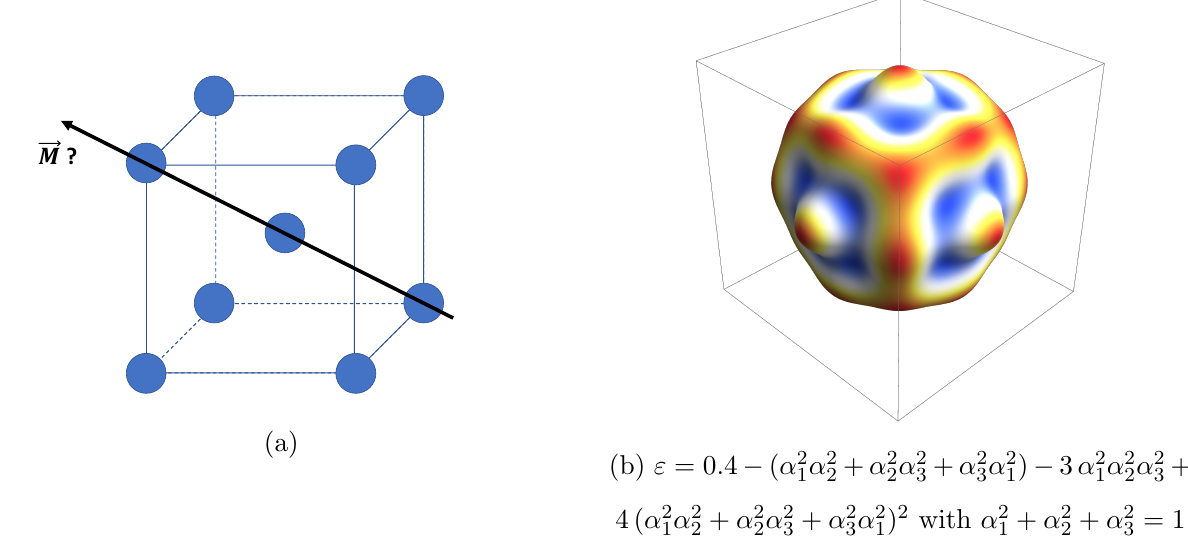
Fig. 1. Left: Schematic of a bcc crystal unit cell, with the overall magnetisation vector being oriented along one of the (cid:104) 111 (cid:105) directions, corresponding to a possible easy axis. Right: Spherical plot of a cubic anisotropy energy density ε considering terms up to eighth order. The magnitude of ε is represented by the distance from the cube centre and the colour code. The global minima (blue colour) remote from cubic high symmetry directions (such as in [4]) are clearly